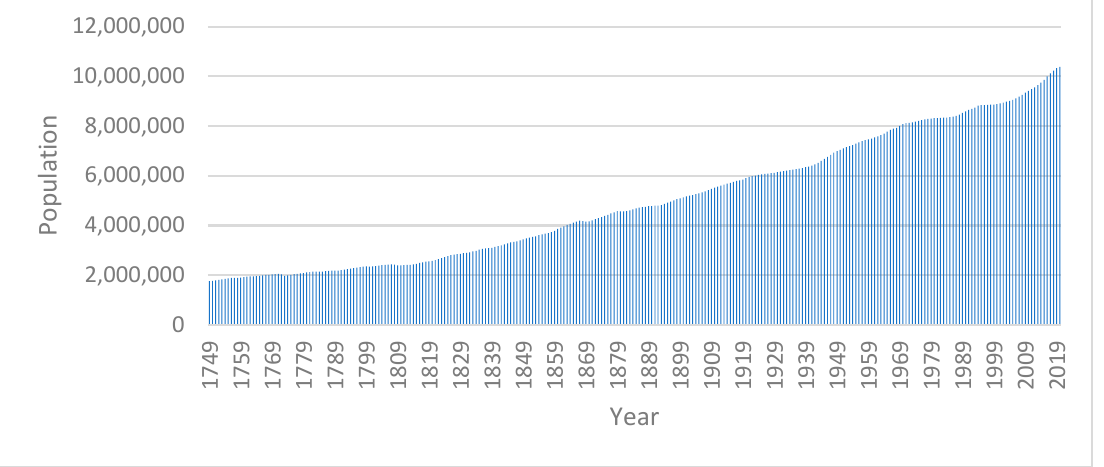
Figure 1. Population development in Sweden [69].